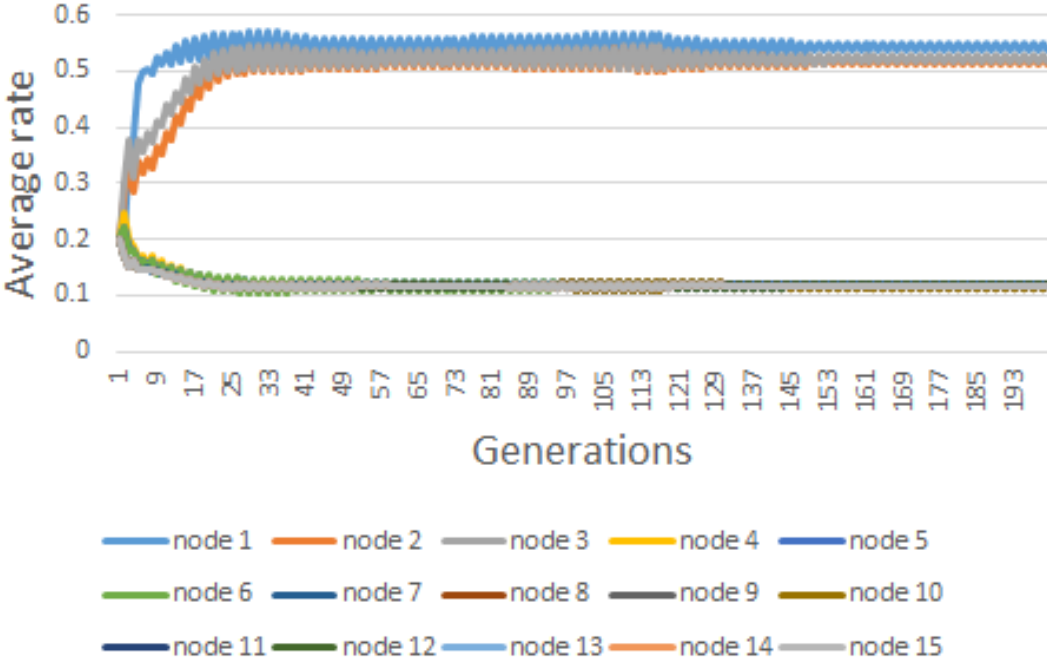
Figure 8. Evolution graphs for average attack for the nodes of the case study. The defender’s budget equals to 3.0. The x-axis presents the generations. The y-axis presents the evolution of average rates.